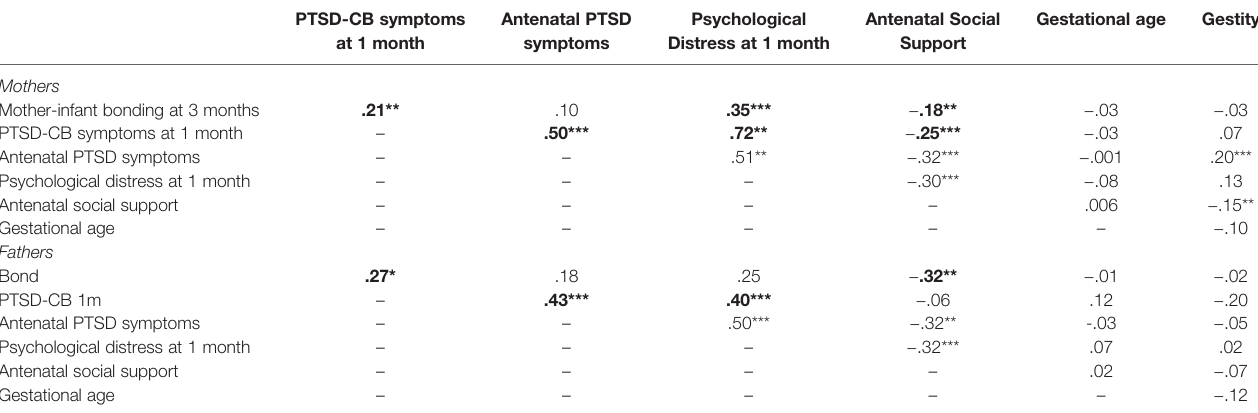
TABLE 3 | Bivarate pearson correlations between variables of interests and potential covariates for mothers and